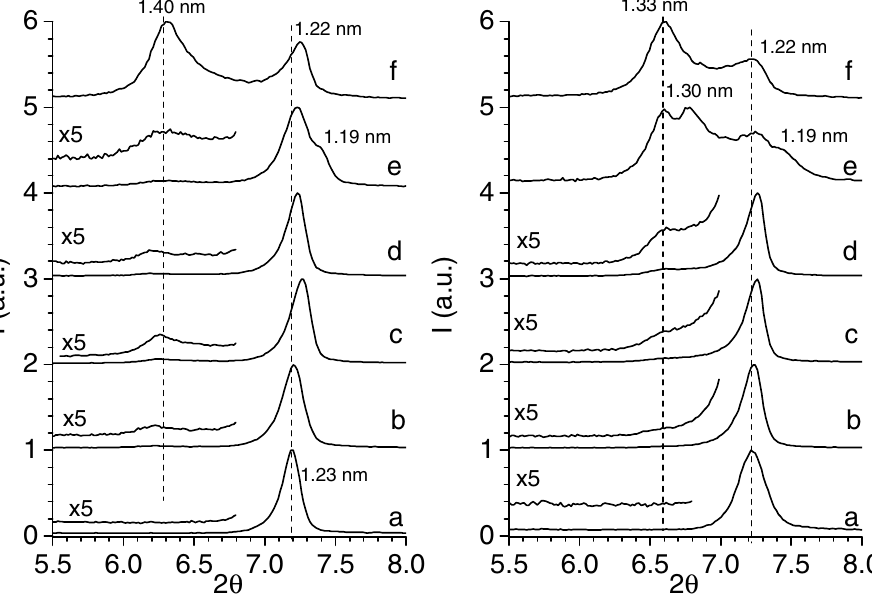
Figure 1. XRD in the 5–8° 2 θ range of Mica-2 ( n = 2), left graph, and, Mica-4 ( n = 4), right graph. ( a ) NaM n , ( b ) Ch-NaM n -A, ( c ) Ch-NaM n -B, ( d ) Ch-NaM n -C, ( e ) Ch-NaM n -D, and, ( f ) Ch-NaM n